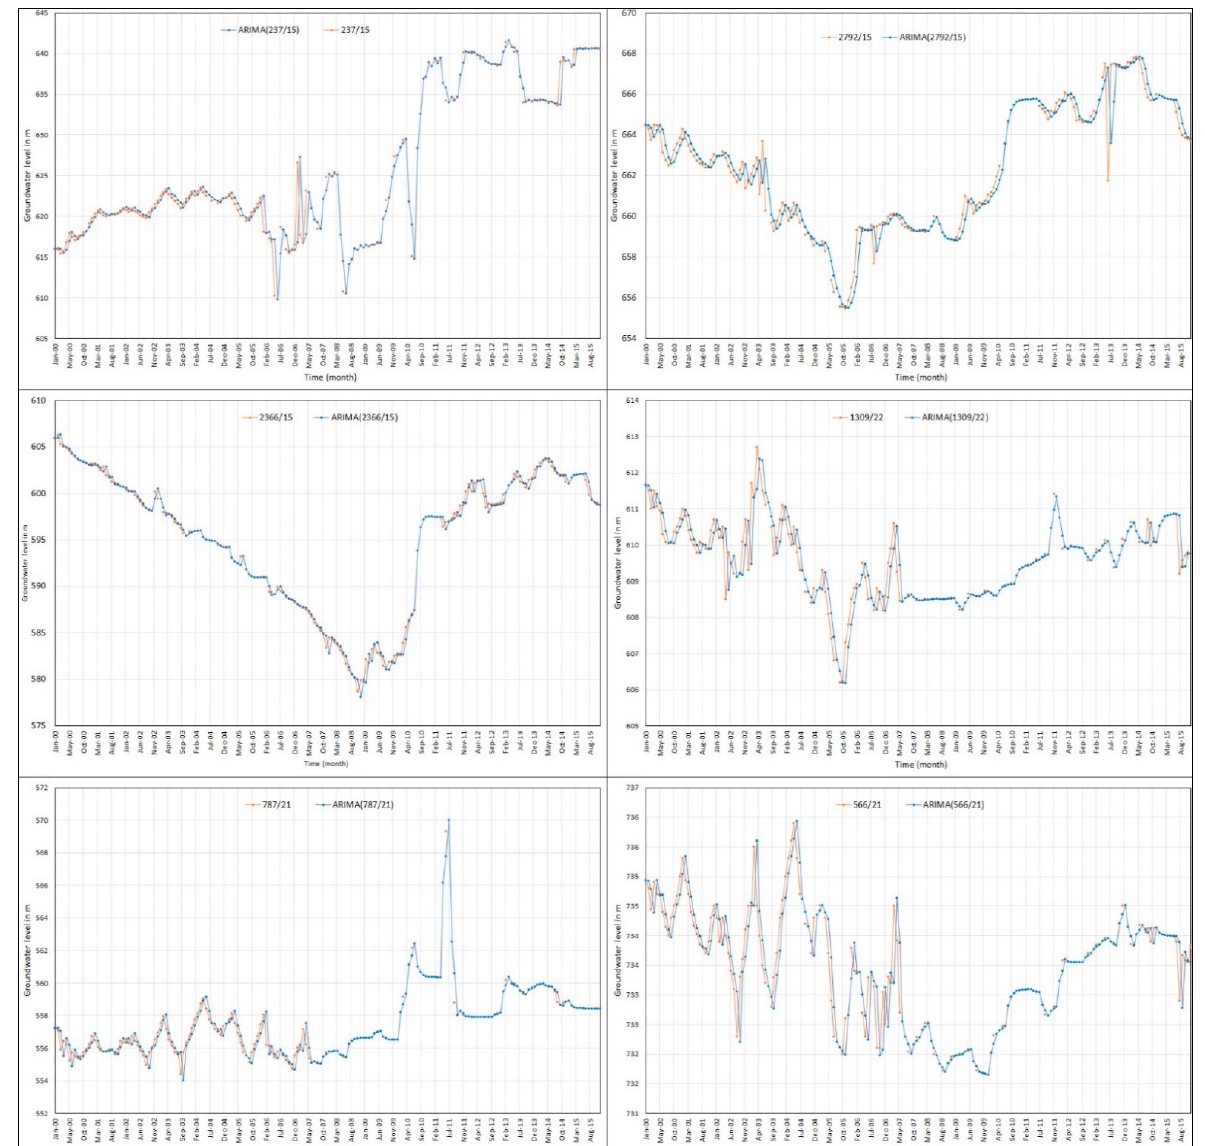
Figure 12. Comparison between measured and reconstructed groundwater level using ARIMA model for the six borehole piezometers .